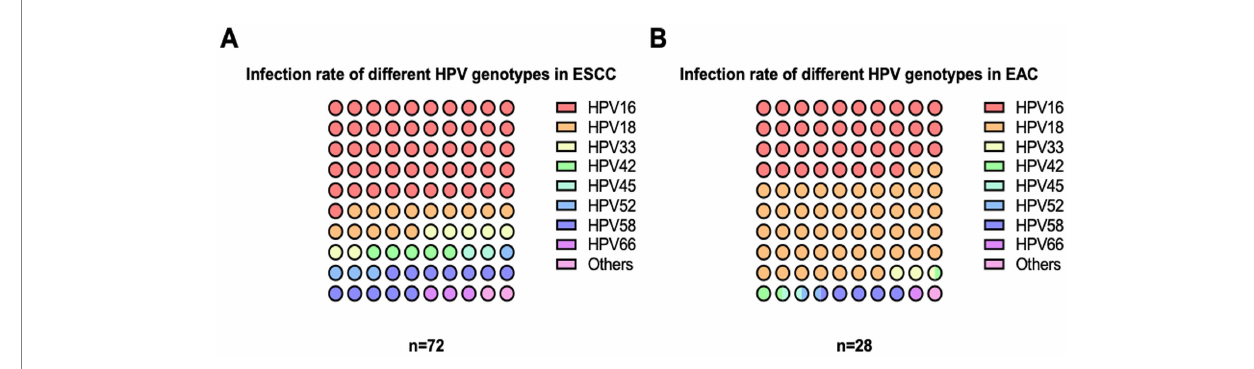
FIGURE 2 Distribution of HPV genotypes in EC tissues. The dissemination of circulated HPV genotypes in each EC subtype indicated that HPV16, HPV18, and HPV58 were the top three predominated genotypes in ESCC (A) and EAC (B) , respectively.